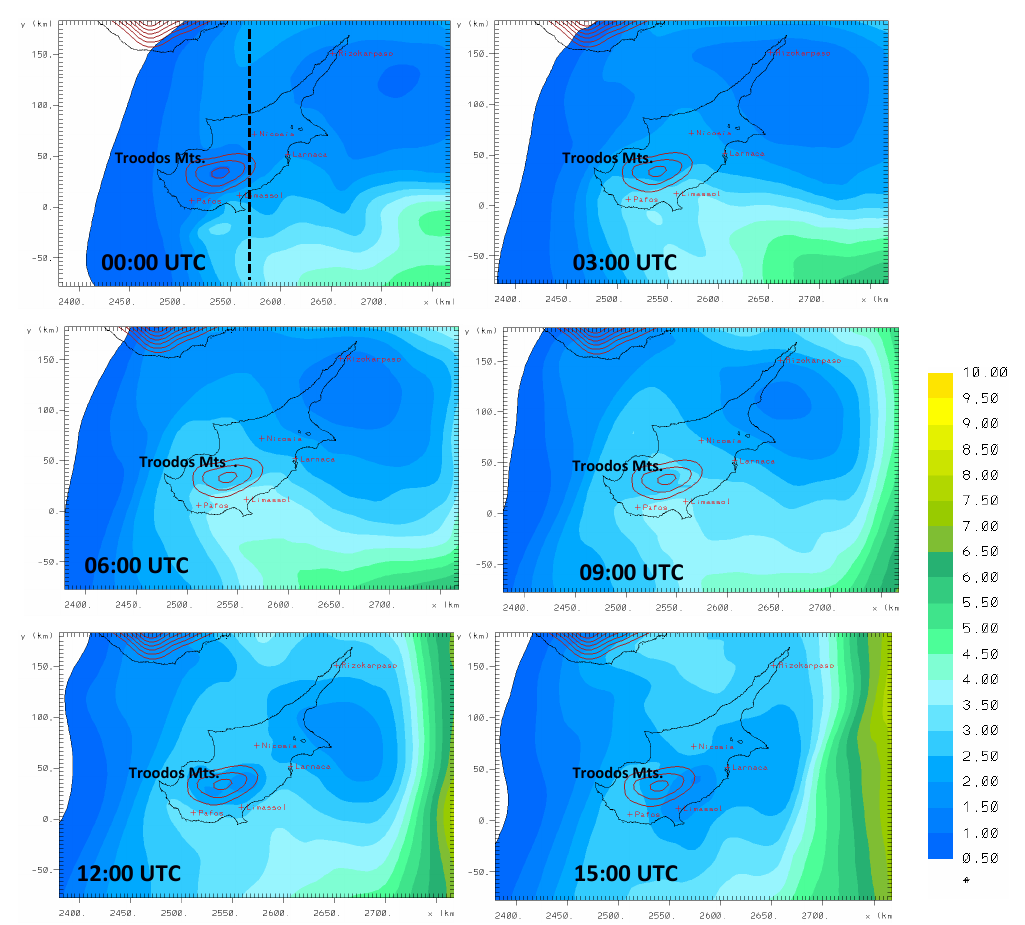
Figure 12. Model 550nm AOT over Cyprus during 00:00–15:00UTC, 8 September 2015; zoom from the second (4km × 4km) model domain. The dashed black line shows the location of the cross sections in Fig.